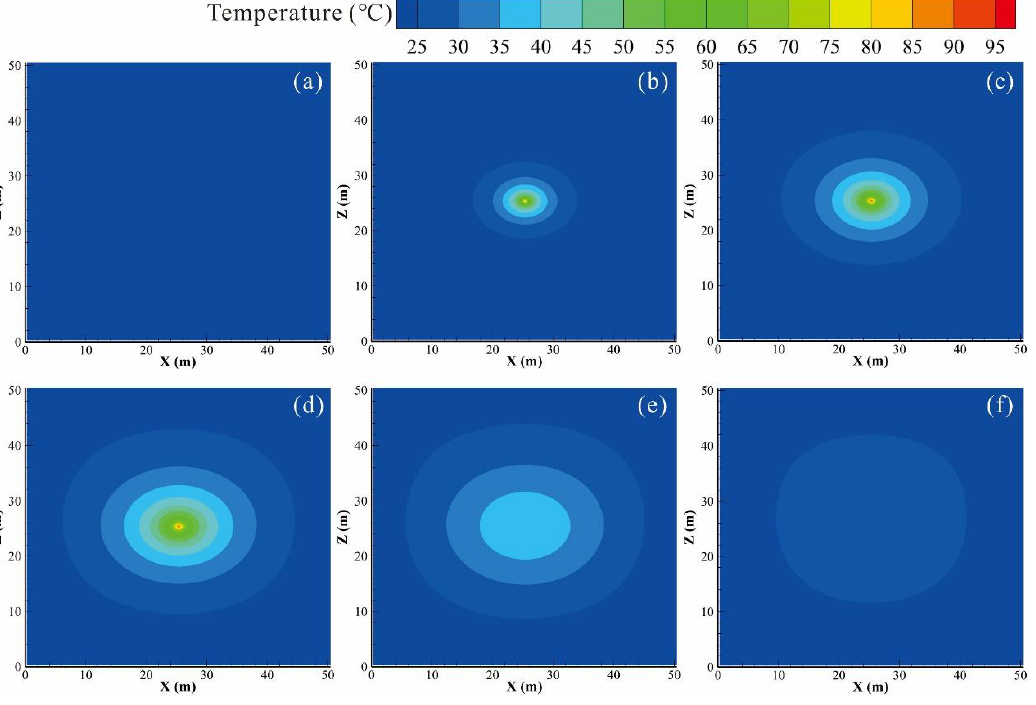
Figure 11. Spatial distributions of model predicted temperatures at ( a ) 496.5 days, ( b ) 938.5 days, ( c ) 1668.5 days, ( d ) 2763.5 days, ( e ) 3128.5 days, and ( f ) 4588.5 days.